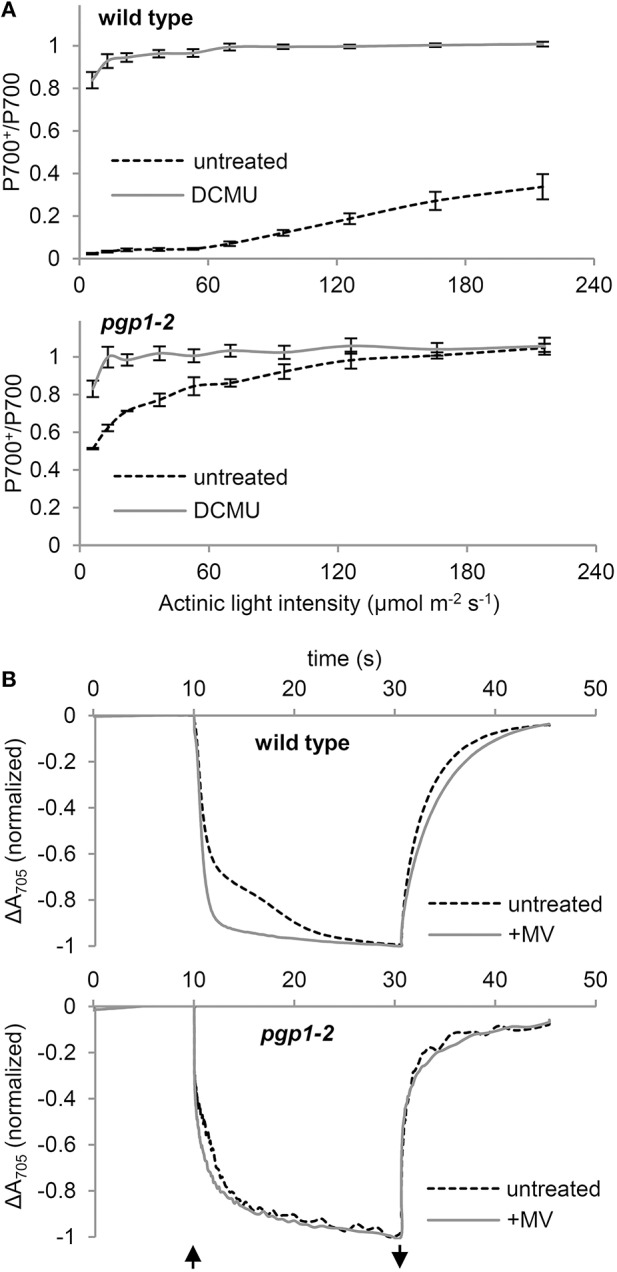
P700 oxidation kinetics in leaf samples. (A) Light-response curve of P700 oxidation in the absence or presence of DCMU. (B) P700 oxidation-reduction kinetics in response to far-red light irradiation in the absence or presence of 1 mM methylviologen (MV). The upward and downward arrows represent the start and end of far-red light illumination, respectively.